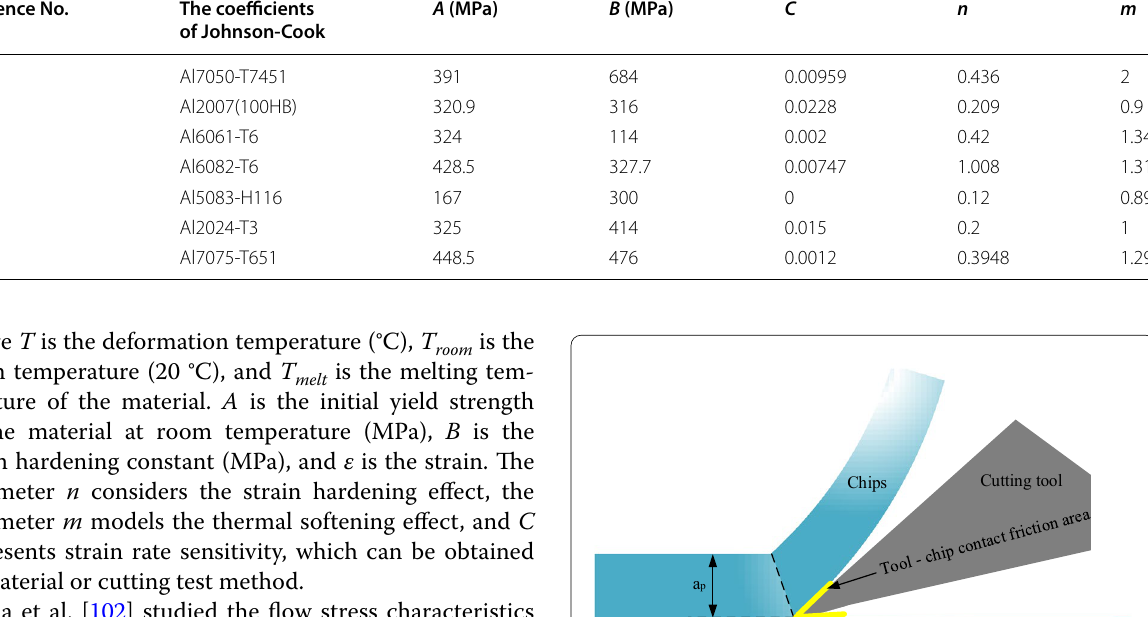
Table 3 Johnson-Cook constitutive equation coefficients of aeronautical aluminum alloys Reference No. The coefficients of Johnson-Cook